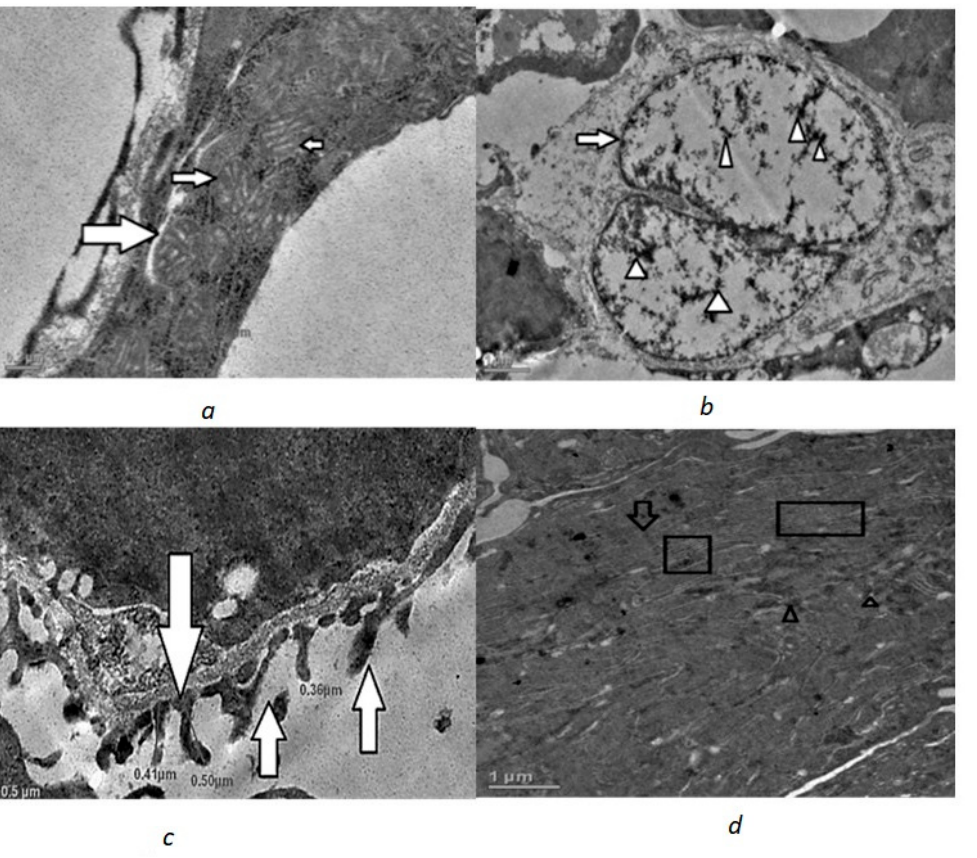
Figure 1. Transmission electron micrographs of control renal cells with intact normal architecture of cellular organelles: ( a ) normal mitochondria with distinct cristae (white filled arrow) (scale 0.2 µm); ( b ) nucleus, though binucleate (white filled arrow) but with uniformly distributed chromatin (white arrow head) (scale 1 µm); ( c ) pedicel with infiltration slits (white filled arrow) (scale 0.5 µm); ( d ) stacks of endoplasmic reticulum (boxed), mitochondria (arrow) and lysosomes (arrow head) (scale 1 µm).